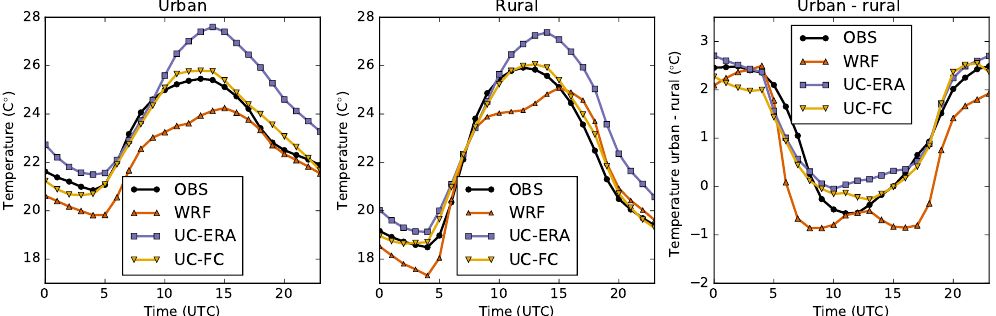
Figure 4. Average daily temperature cycle in the urban (left) and rural (middle) stations. The difference urban minus rural is shown in the panel on the right. The “UC-ERA”, “UC-FC” and “WRF” legend codes are defined in Sect. 2, while “OBS” represents the